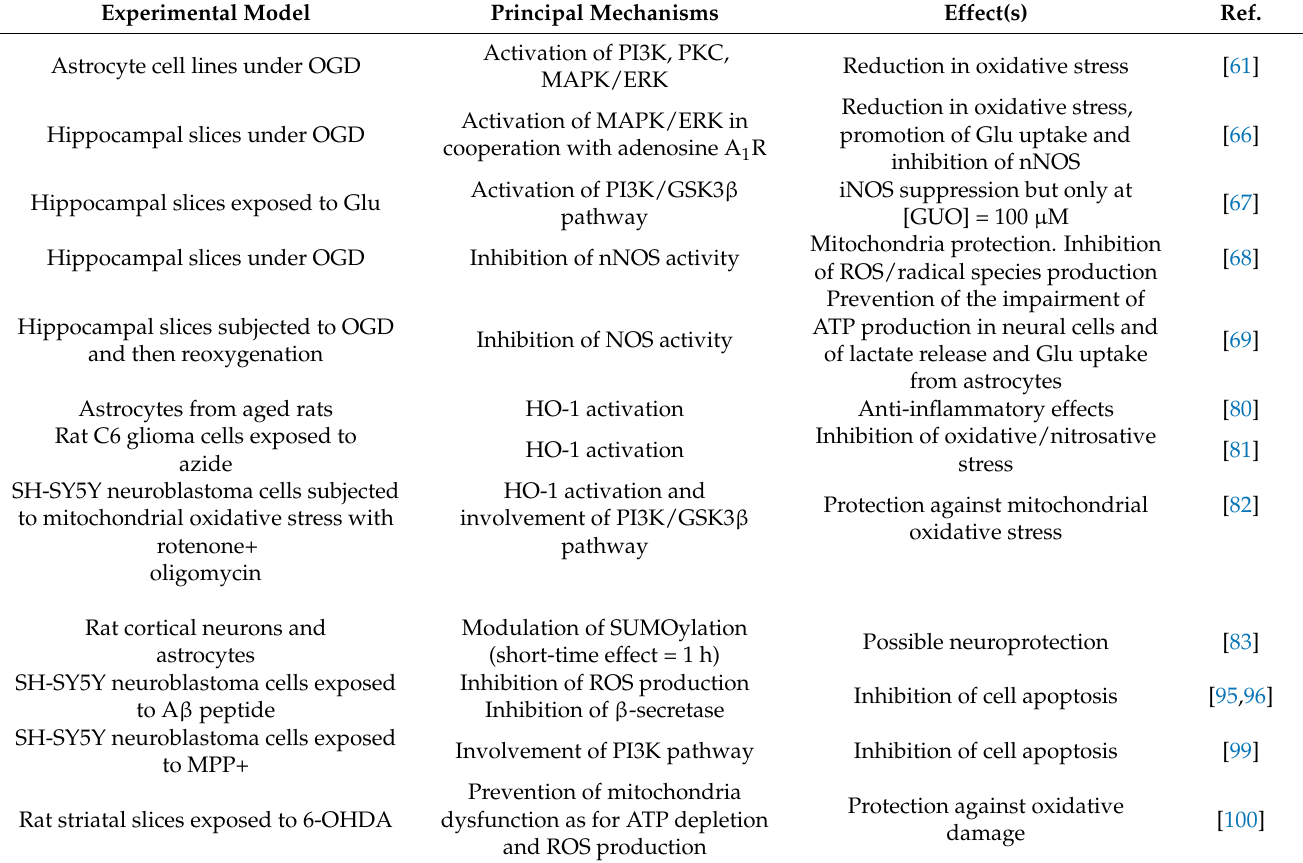
Table 1. GUO neuroprotective activity coupled to antioxidative properties in in vitro models. Experimental